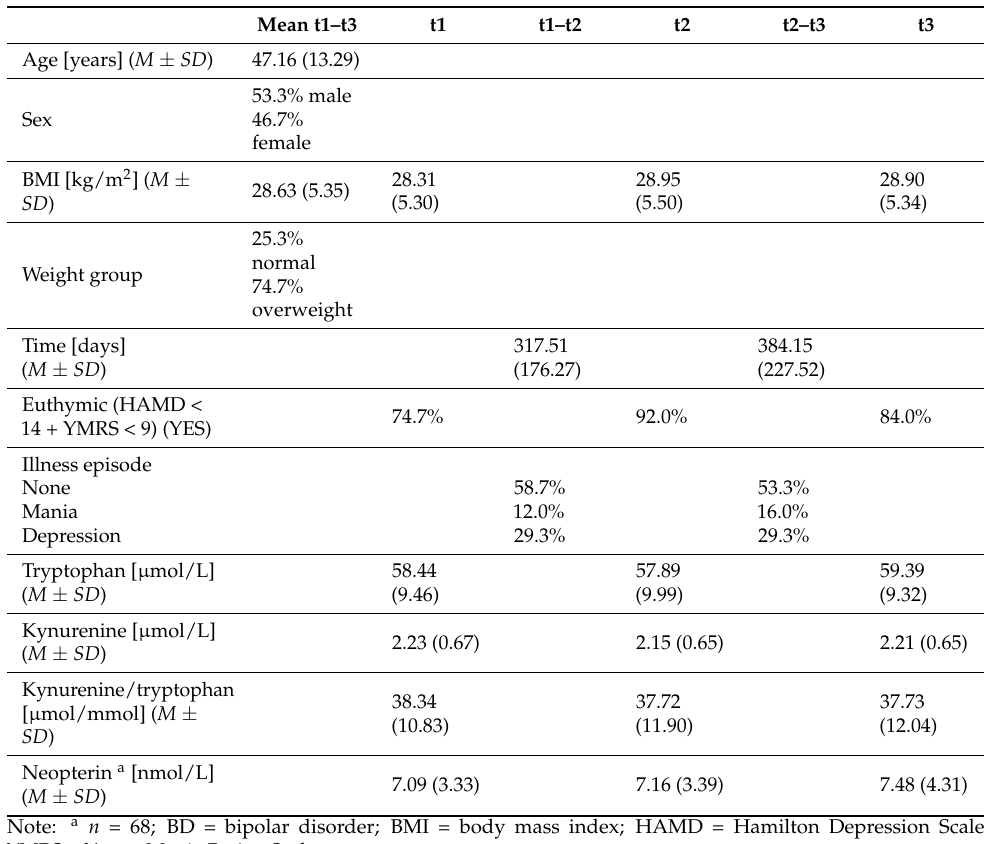
Table 2. Demographic data of individuals with BD ( n = 75) in a longitudinal setting of three measurement time